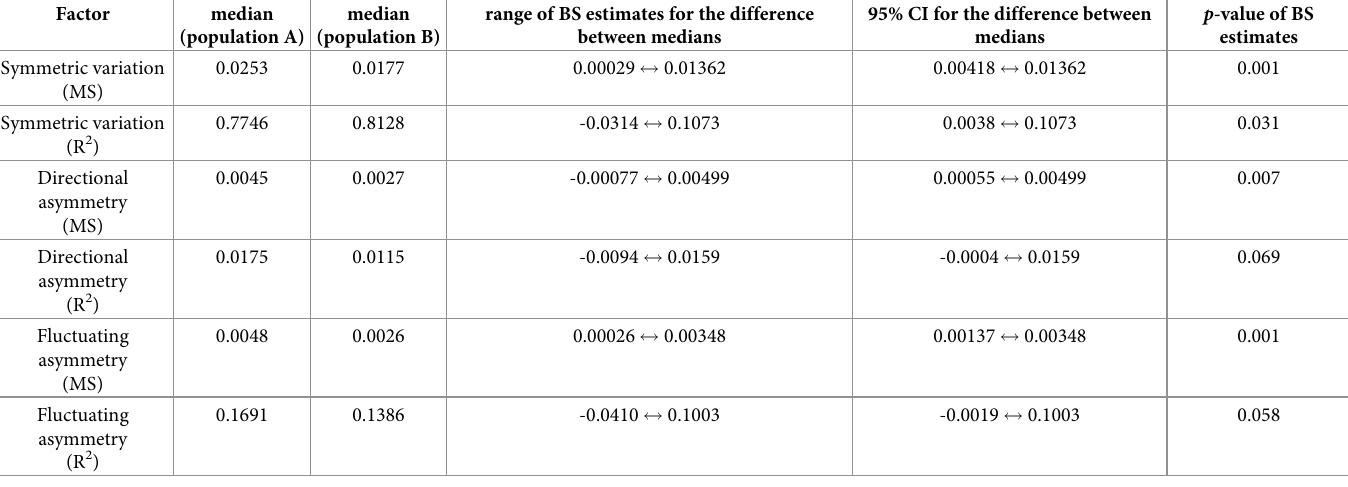
Table 4. Results of bootstrap tests for the difference in components of segment shape variation between populations represented by configurations with unslid equidistant